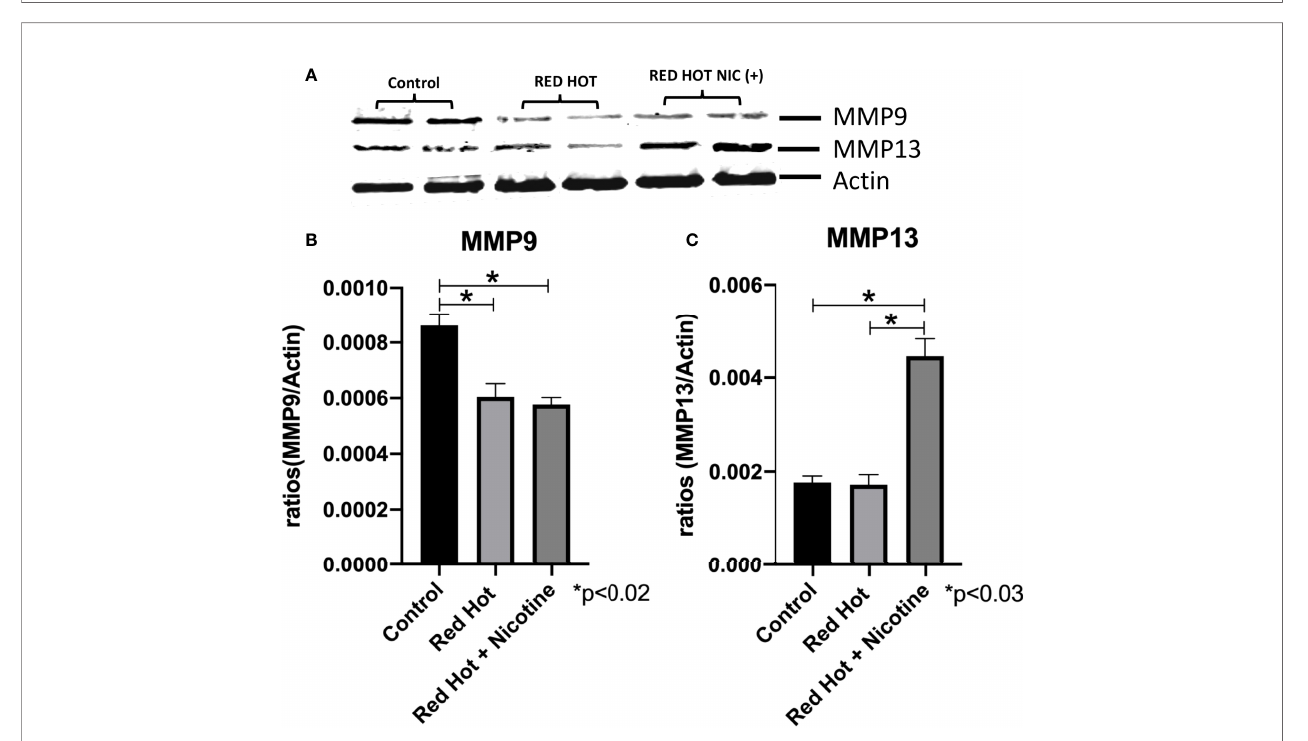
FIGURE 6 | MMP-9 and MMP-13 during Red Hot EVE treatment of Ca9-22 cells. A representative Ca9-22 MMP9 and 13 western blot picture is shown in (A) Western blot analysis showed decreased MMP-9 when Ca9-22 cells were treated with Red Hot EVE in the presence or absence of nicotine (B) . MMP-13 was increased in cells exposed to Red Hot EVE with nicotine (C) when compared to untreated control cells. Data are shown with * p ≤